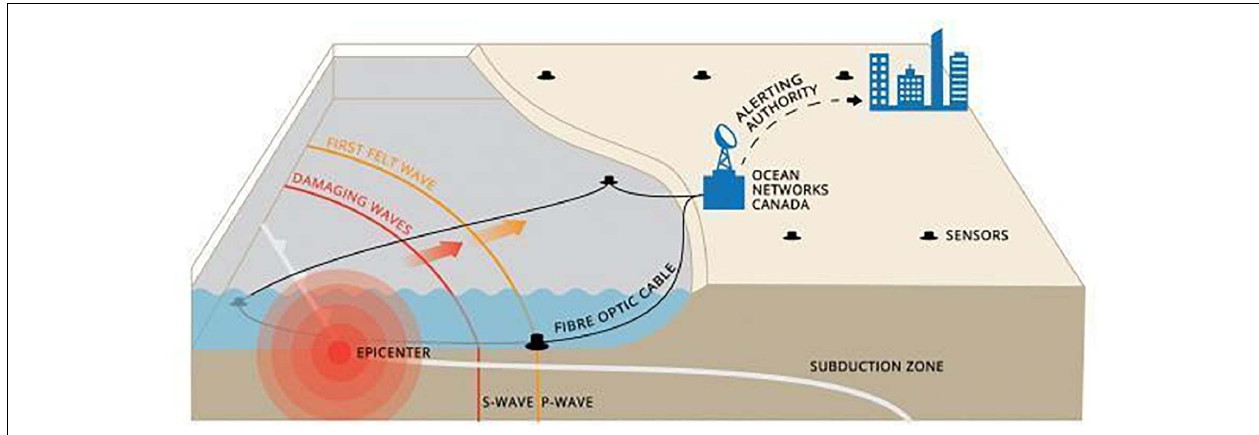
FIGURE 6 | The sketch depicts how combining onshore and offshore sensor networks [e.g., underwater cables equipped with seismometers and Bottom Pressure Recorder (BPRs)] at coastal hazard zones such as the subduction zone offshore Canada depicted here increase event detection reliability and warning time. (Image courtesy of Ocean Networks